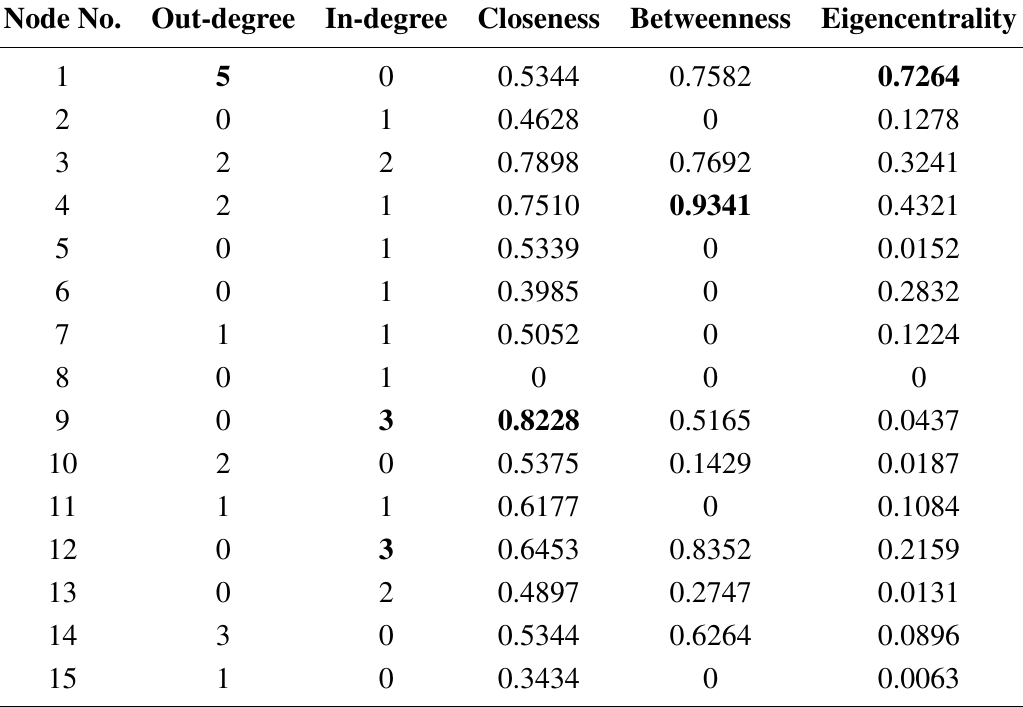
Table 2. Centrality